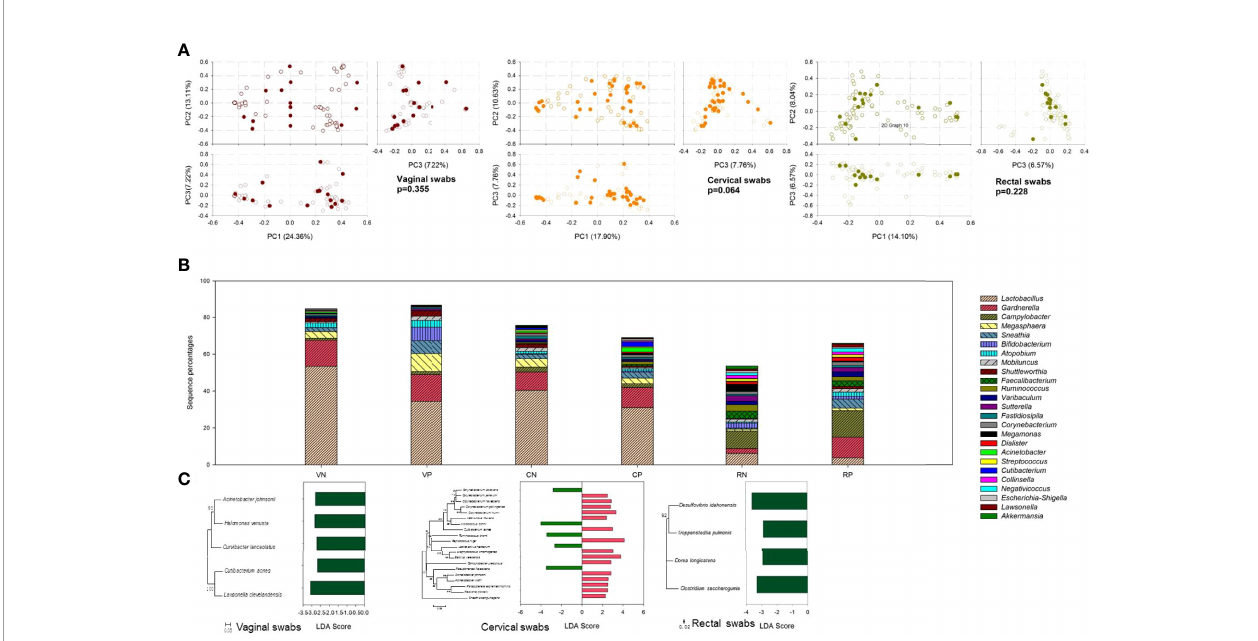
FIGURE 4 | The effect of HPV infection on microbial community composition. (A) PCA plot based on the relative taxon abundance in vaginal, cervical, and rectal swab samples from HPV-negative (open circles) and HPV-positive (dark colored circles) subjects. (B) Microbial community composition at the genus level compared in vaginal, cervical, and rectal swab samples between HPV-negative and HPV-positive samples. VN, vaginal swabs from HPV-negative subjects; VP, vaginal swabs from HPV-positive subjects; CN, cervical swabs from HPV-negative subjects; CP, cervical swabs from HPV-positive subjects; RN, rectal swabs from HPV-negative subjects; RP, rectal swabs from HPV-positive subjects. (C) LDA value of LefSe analysis distribution histogram of the OTUs displayed signi fi cant differences between HPV-negative and HPV-positive